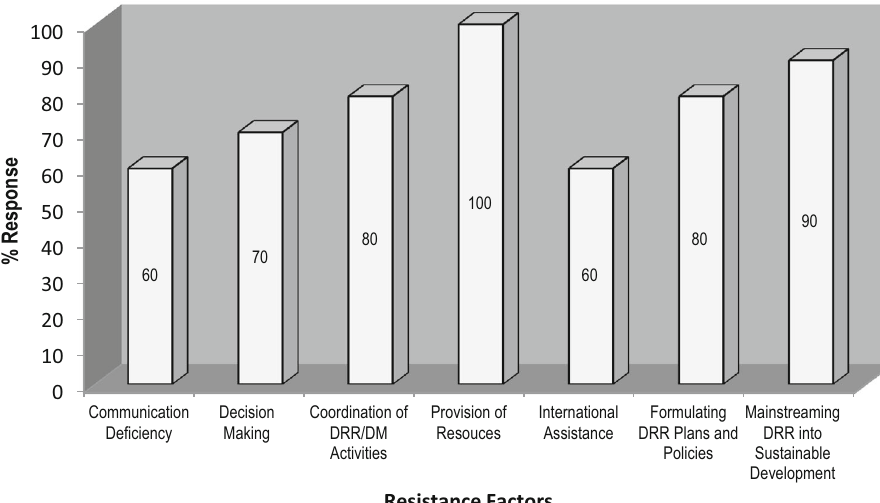
Fig. 6 Percentage of responses on resistance factors in Cameroon’s DM system.